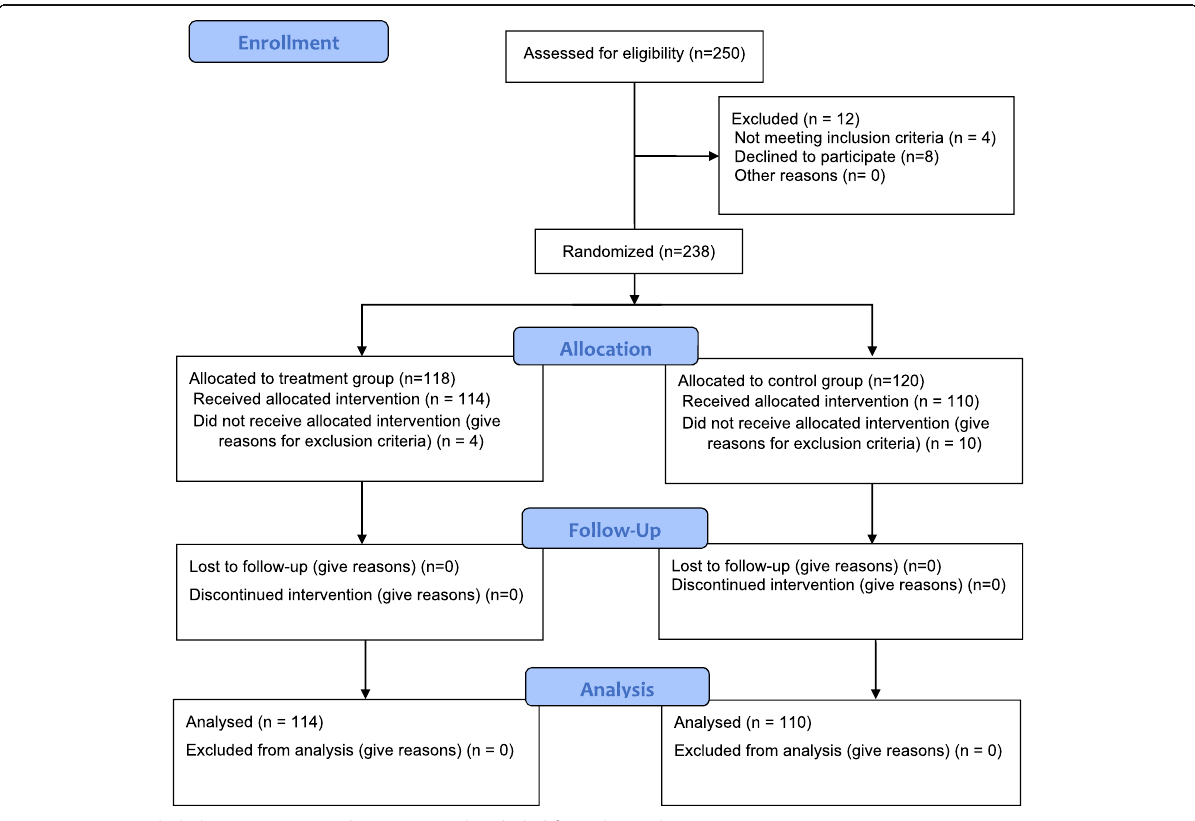
Fig. 1 Patients included in screening, randomization and excluded from the study